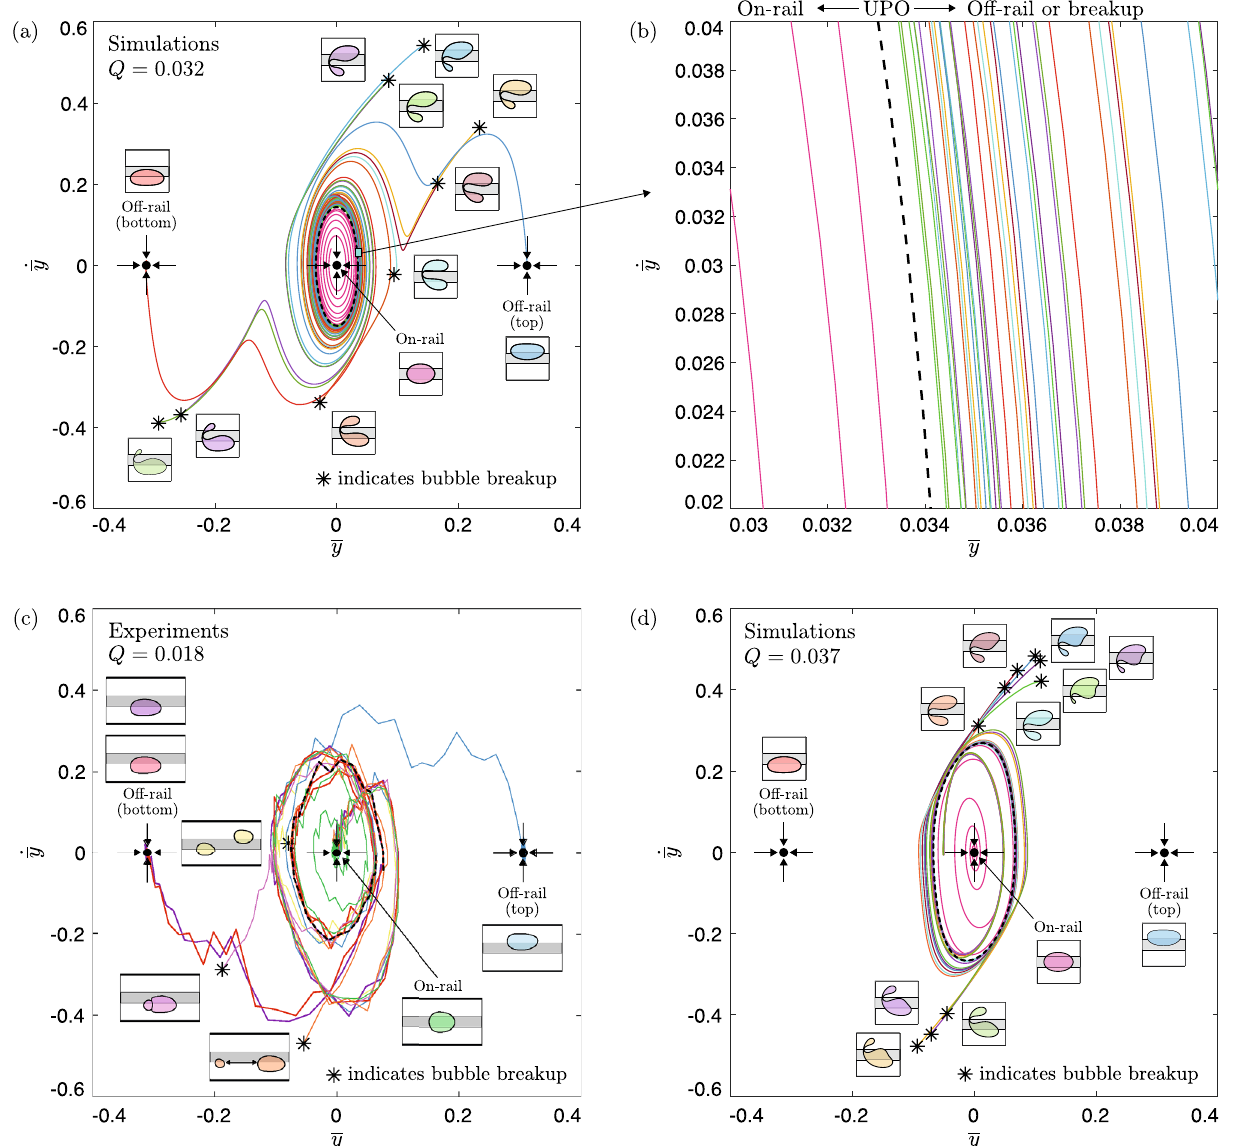
˙ y ) plane at Q = 0.032 . The UPO